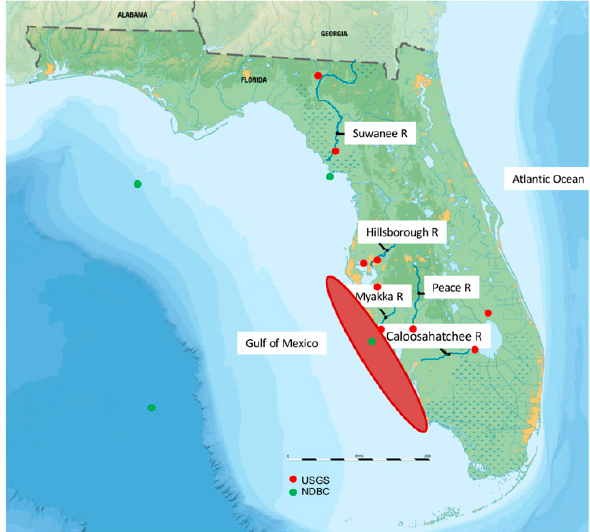
Figure 1. Map of the West Florida Shelf (WFS) showing the region in red where Karenia brevis blooms are most frequently observed, and the major rivers that discharge onto the WFS and for which nutrient (total nitrogen and total phosphorus) data are available. Red dots mark the United States Geological Survey (USGS) stations and green dots mark the National Data Buoy Center stations (Station 42,039, 28.787N 86.007W; Cedar Key, 29.12N 83.02 W and Fort Myers 26.65N. 81.88W) from which wind and temperature data were acquired.